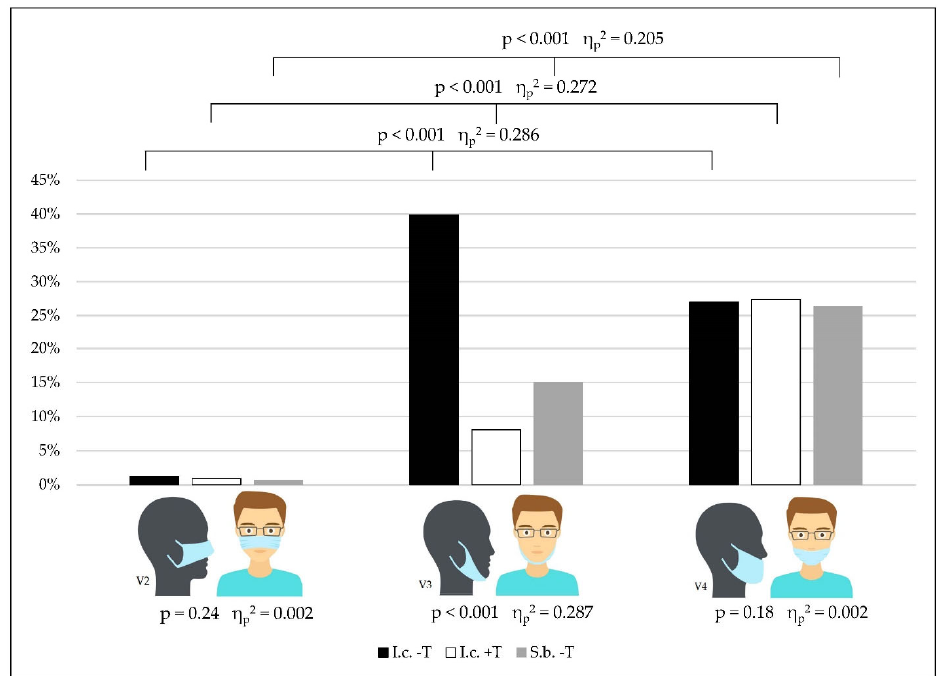
Figure 4. Percentages of self ‐ estimated time of incorrect mask wearing (according to different situations in the schools and different variations in mask wearing).